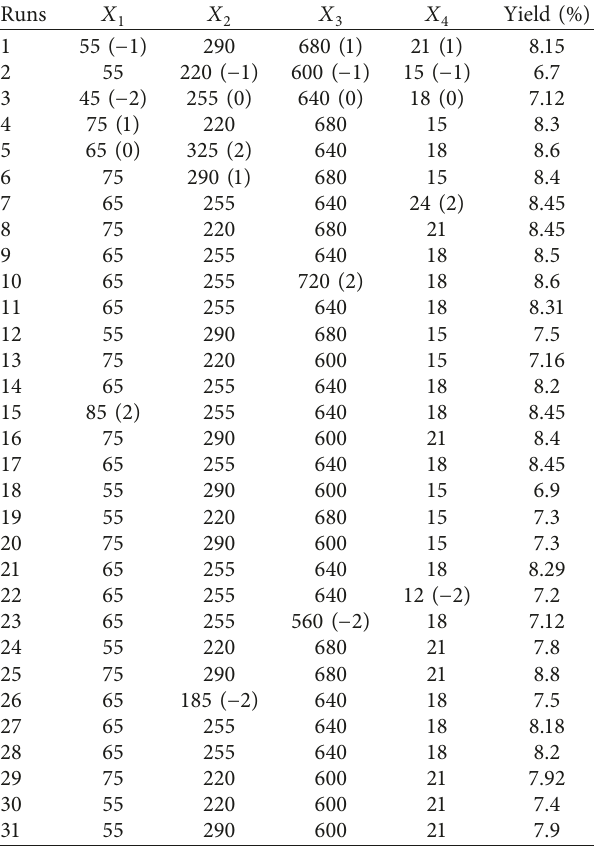
Table 2: Experimental design and results of the yield of barley hordein.